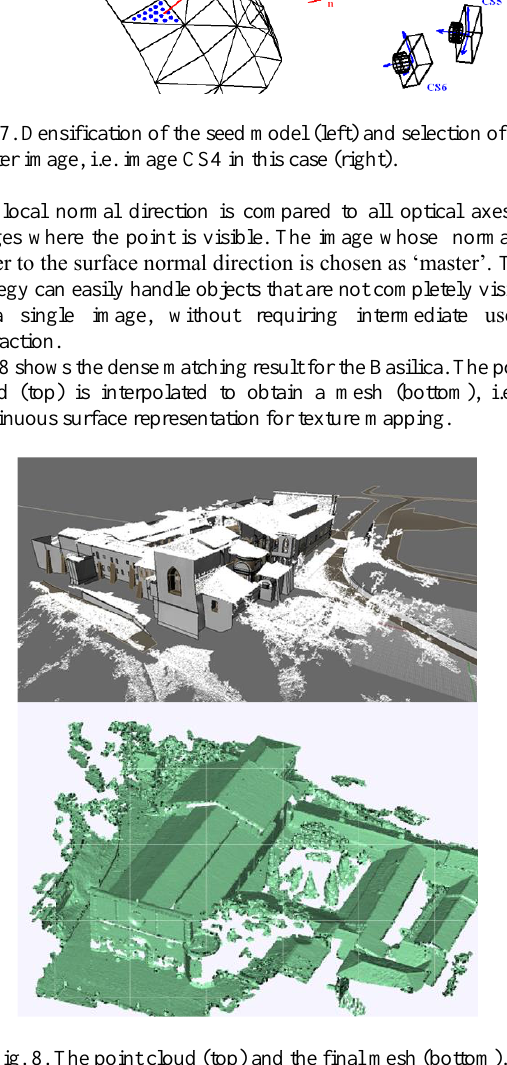
Fig. 8. The point cloud (top) and the final mesh (bottom).